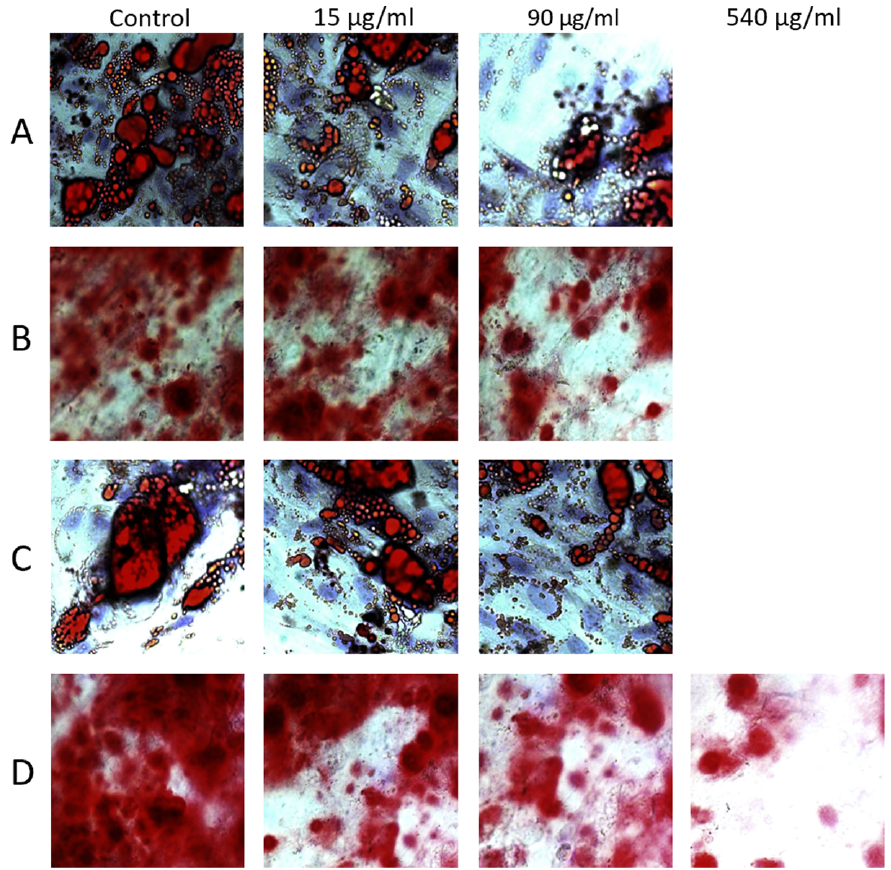
Figure 7. Example pictures of adipogenic and osteogenic differentiation of ADSCs at 5× magnification. Oil Red O ( A , C ) and Alizarin Red ( B , D ) analysis of differentiation potential for ADSCs treated with clindamycin ( A , B ) and cefazolin ( C , D ). ADSCs were not able to differentiate into adipocytes after treatment with concentrations higher than 90 µ g/mL for both antibiotics, and into osteoblasts after incubation with concentrations higher than 90 µ g/mL clindamycin and 540 µ g/mL cefazolin.